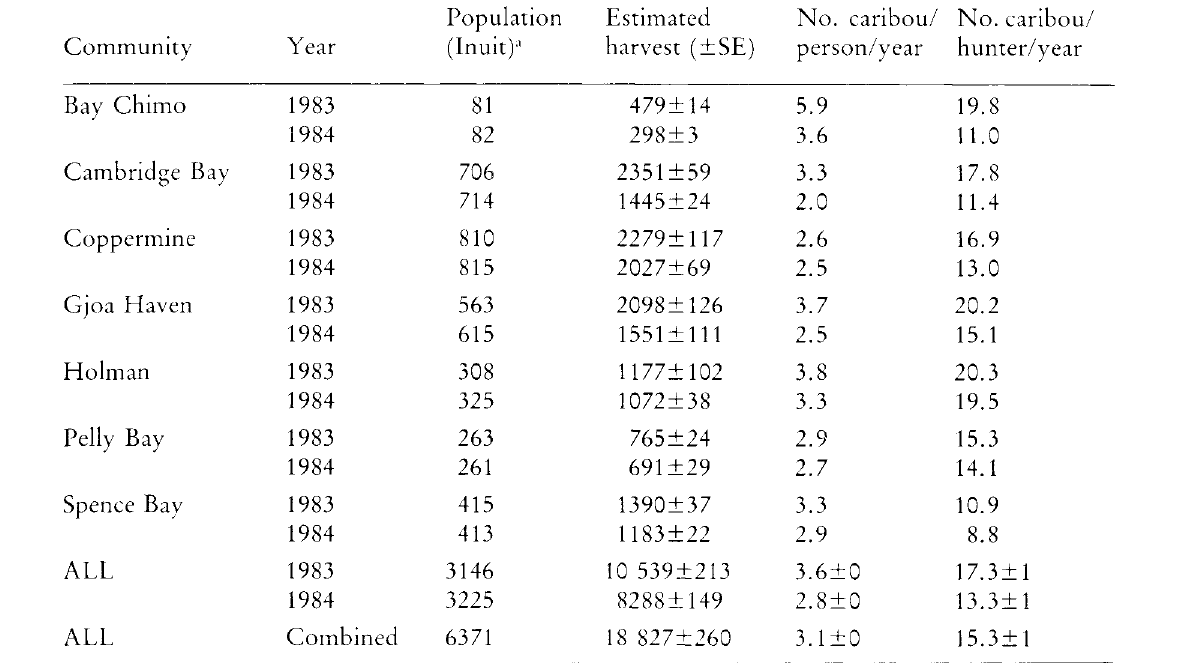
Population Estimated N o. caribou/ No. caribou/